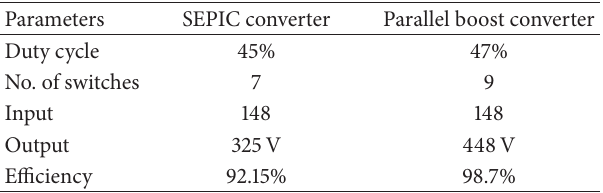
Table 4: Comparison of SEPIC and parallel boost